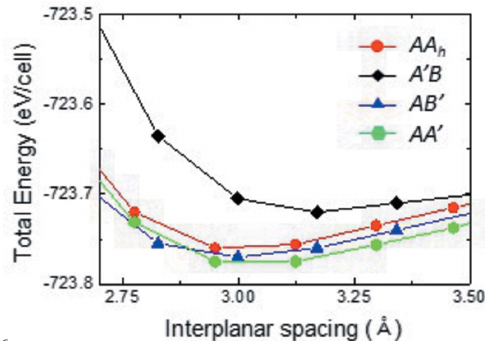
Figure 6 Calculated stacking energies with stacking structures for bi-layer h -BN. AA 0 stacking is the most stable configuration for